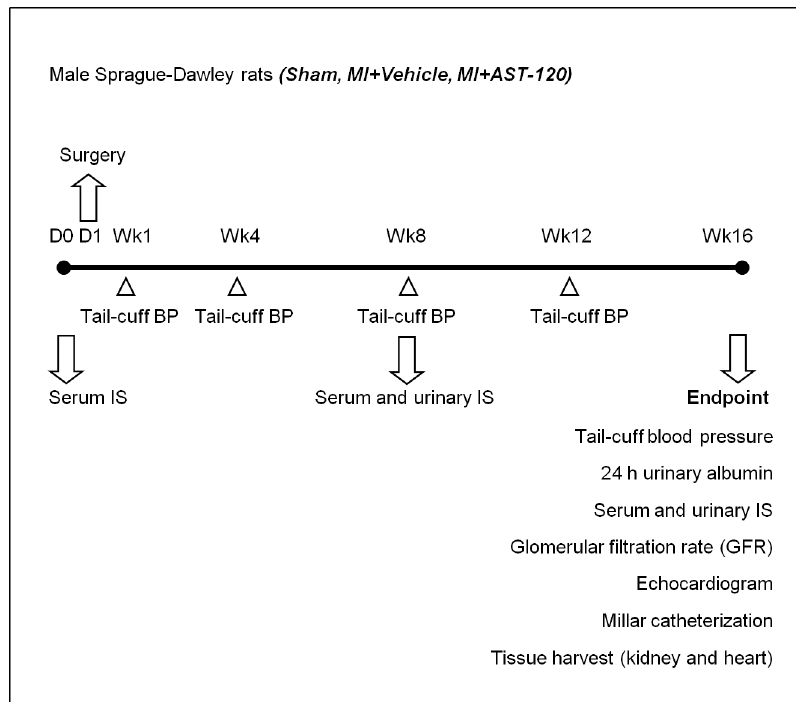
Figure 1. Experimental